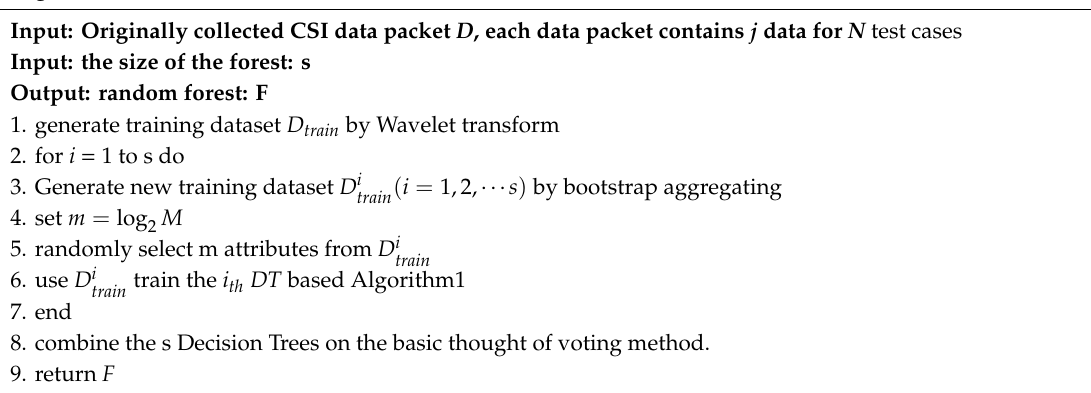
Algorithm 2. Construction of Random